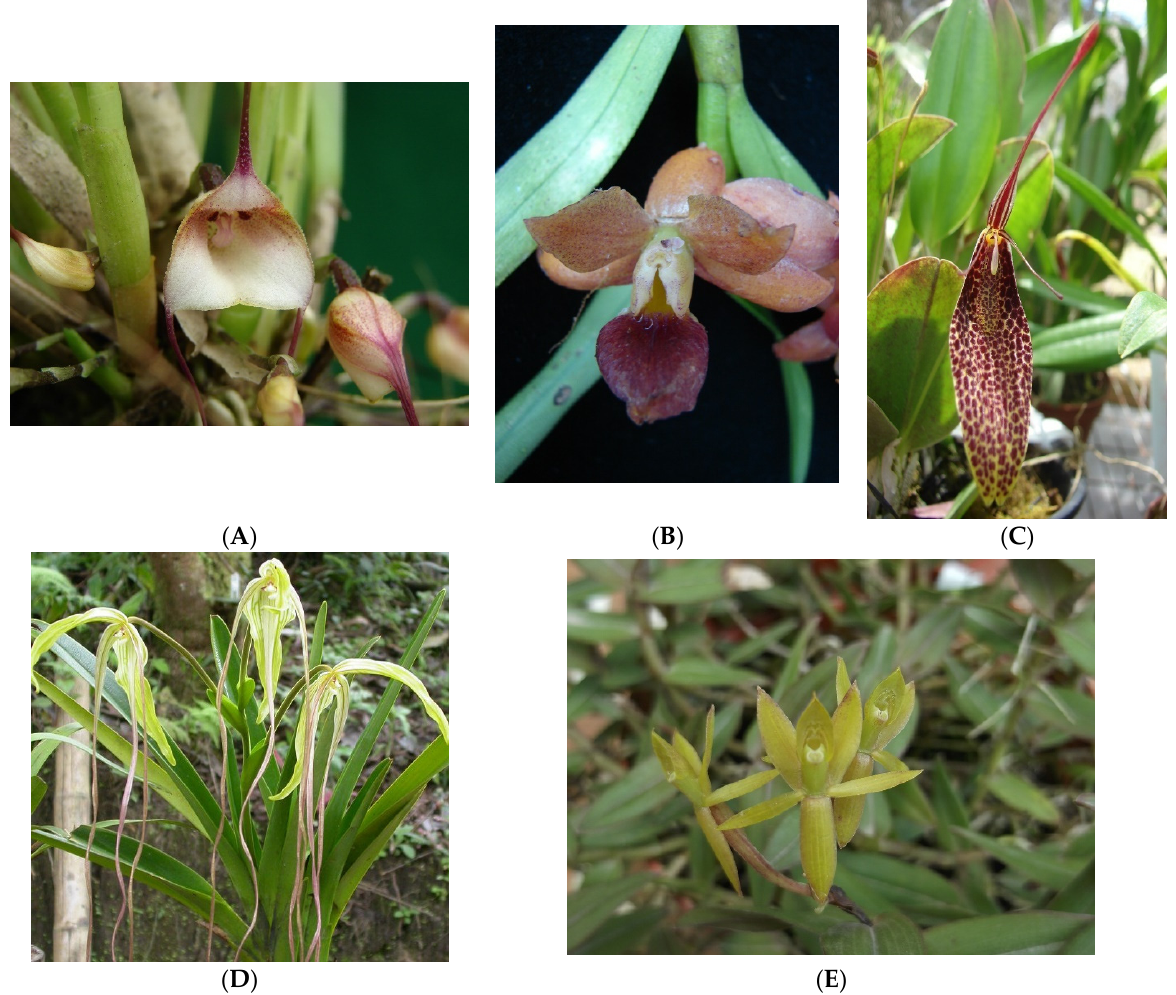
Figure 2. Threatened species in the Chaupisacha and La Reventazón sectors of Pululahua Geobo- tanical Reserve. ( A ). Dracula felix ; ( B ). Epidendrum diothonaeoidess ; ( C ). Phragmipediumlindenii; ( D ) . Restrepia guttulate ; ( E ). E. polyanthogastrium .